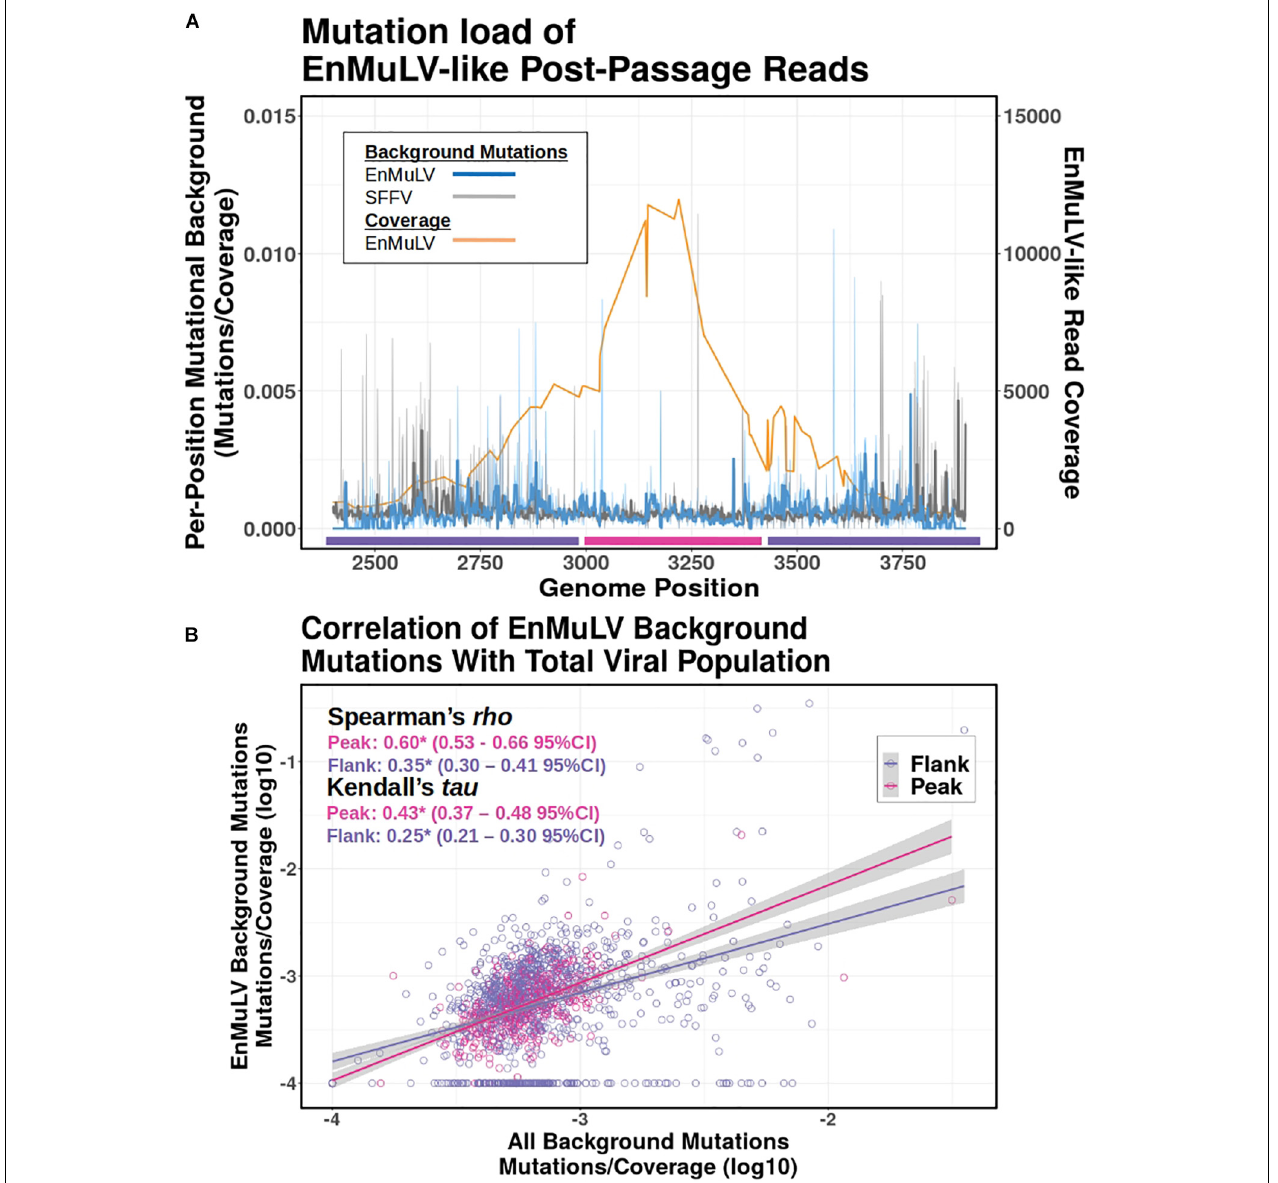
FIGURE 7 | Mutational background of EnMuLV vs. total SFFV population. (A) Average fraction of background mutations detected in Illumina reads from 6 post-passage viral populations on EnMuLV-like reads (light blue) and in the total viral population (gray) aligned to the SFFV-BC genome ( x -axis). Values are calculated as [number of detected variants at position X/estimated coverage at position X]. These raw data are plotted with fine lines while thick lines represent Tukey’s 3R smoothed data to aid visualization. The average coverage of EnMuLV-like reads in the data set are plotted in orange, with scale on the right y -axis. Pink and purple lines along the x-axis delineate genome regions “Peak” and “Flank” used in (B) . (B) The correlation between EnMuLV and Total Mutational Backgrounds for the “Peak” and “Flank” genomic regions are shown. Pink points correspond to genomic positions of SFFV-BC with high EnMuLV-like read coverage (positions 3000–3400) while purple points correspond to the flanking genomic positions (2700–2999 and 3401–3700). Trend lines are inferred from simple linear regressions. Because of non-normality, results for non-parametric Spearman and Kendal correlation tests are shown, with pink and purple corresponding to Peak and Flank genomic regions (respectively) and (*) noting significance of test performed. In parentheses, 95% confidence intervals for tests statistics tau and rho are